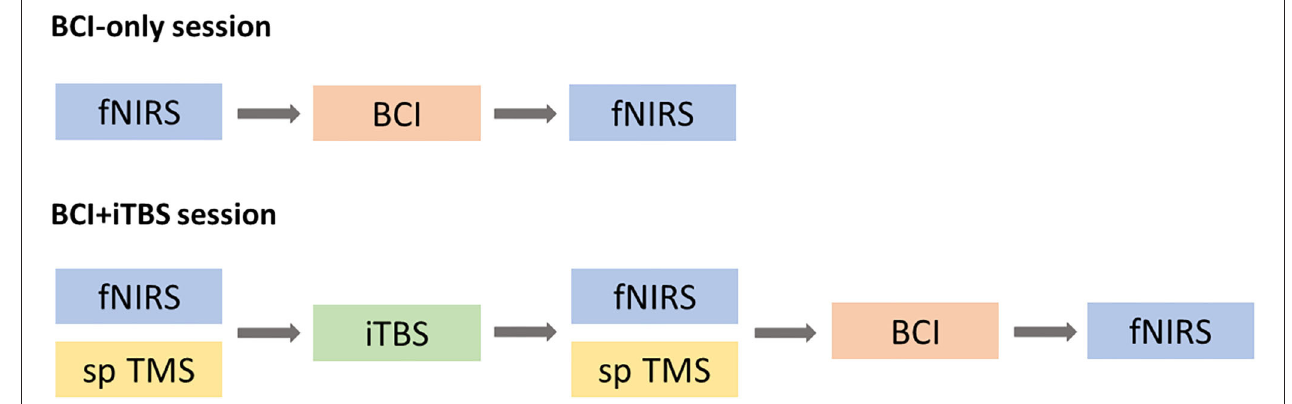
FIGURE 4 | Experimental procedure. In BCI-only session, fNIRS was tested at baseline and after BCI training (top panel). In iTBS + BCI session, fNIRS was tested at three times points: baseline, after TBS and after BCI. Single-pulse (sp) TMS was tested at baseline and after iTBS. The order of those two sessions was